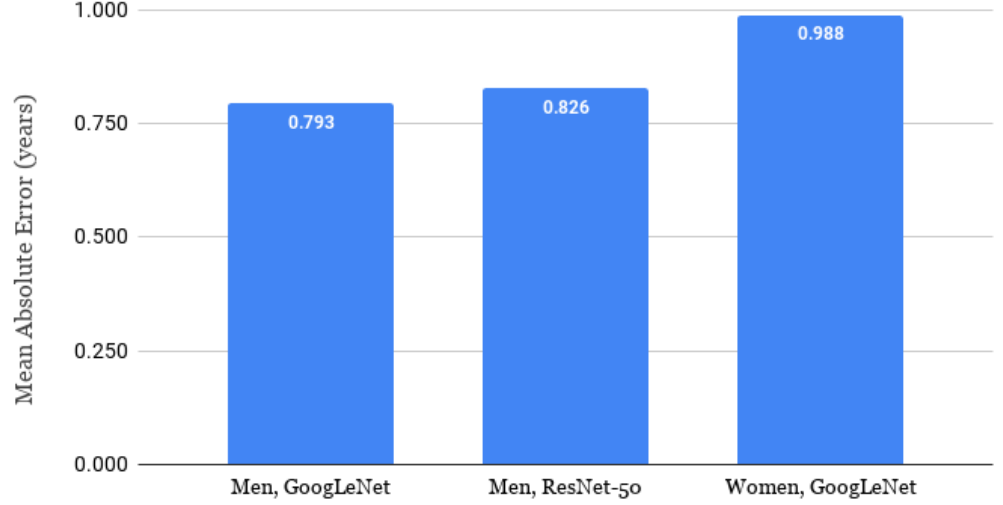
Figure 7. Mean absolute error (MAE) of the best-performing models in the applicable age ranges.